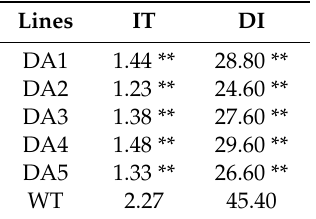
Table 2. Responses of DmAMP1W transgenic wheat to common root